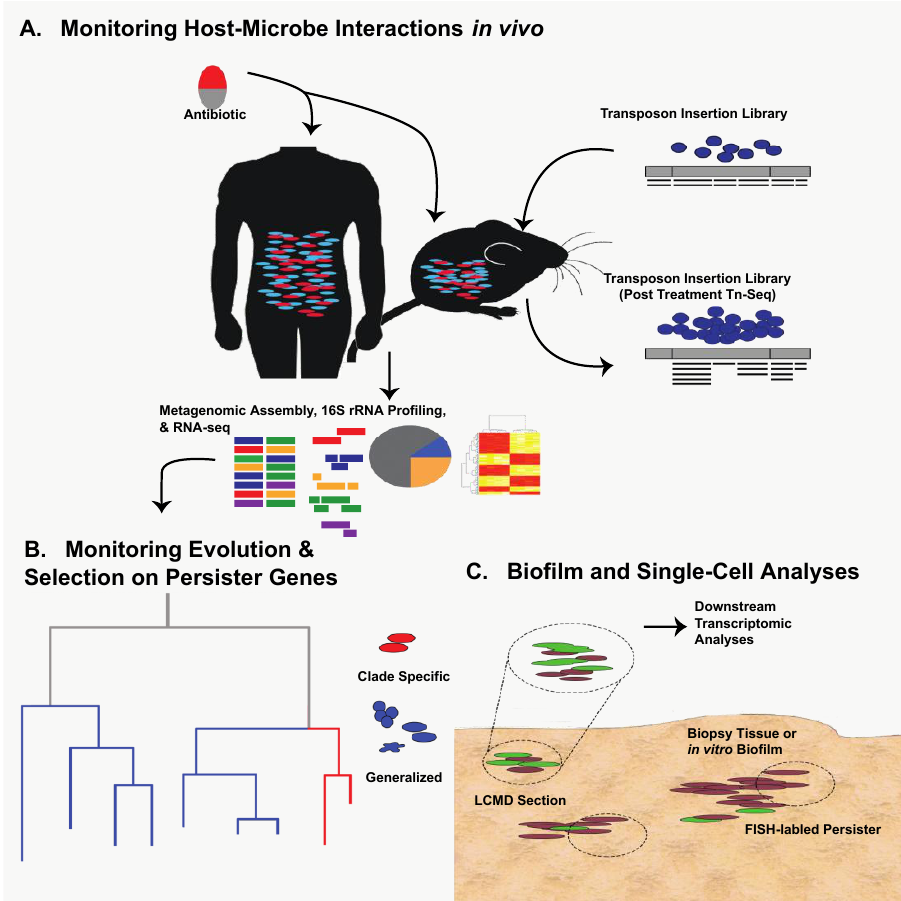
Figure 1. Utilization of next-generation technologies for studying persister cells. ( A ) Both human patients and murine models provide an opportunity to study in vivo persister formation via 16S rRNA profiling, community metagenomics, and RNA-Seq of the intestinal flora following antibiotic exposure. Single-organism persister formation can be studied in vivo through animal infection with high-density transposon insertion libraries and Tn-Seq. ( B ) Metagenomic and RNA-Seq data can be used to study selective pressure on persister genes in either closely related or divergent taxa. This can be done